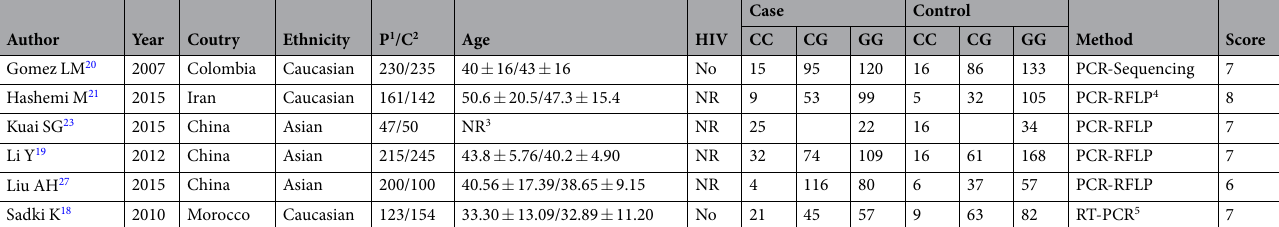
Table 1. Characteristics of the studies involving an association between the MIF-173G/C polymorphism and PTB risk included in the meta-analysis. 1 patient; 2 control; 3 not report; 4 polymerase chain reaction-restriction fragment length polymorphism; 5 real time-polymerase chain reaction.